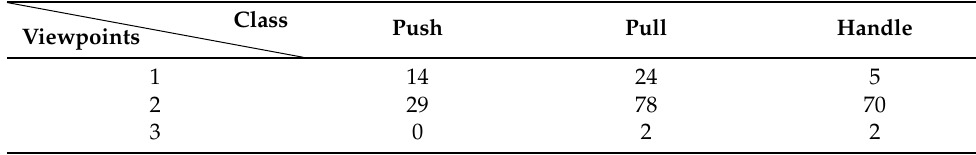
Table 2. Distribution of viewpoints across